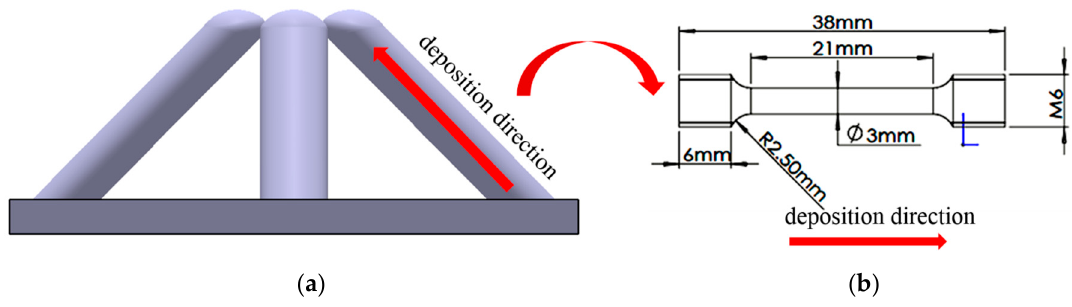
Figure 6. ( a ) Schematic illustration of the way to take the metallographic specimen; ( b ) size of the tensile test sample .